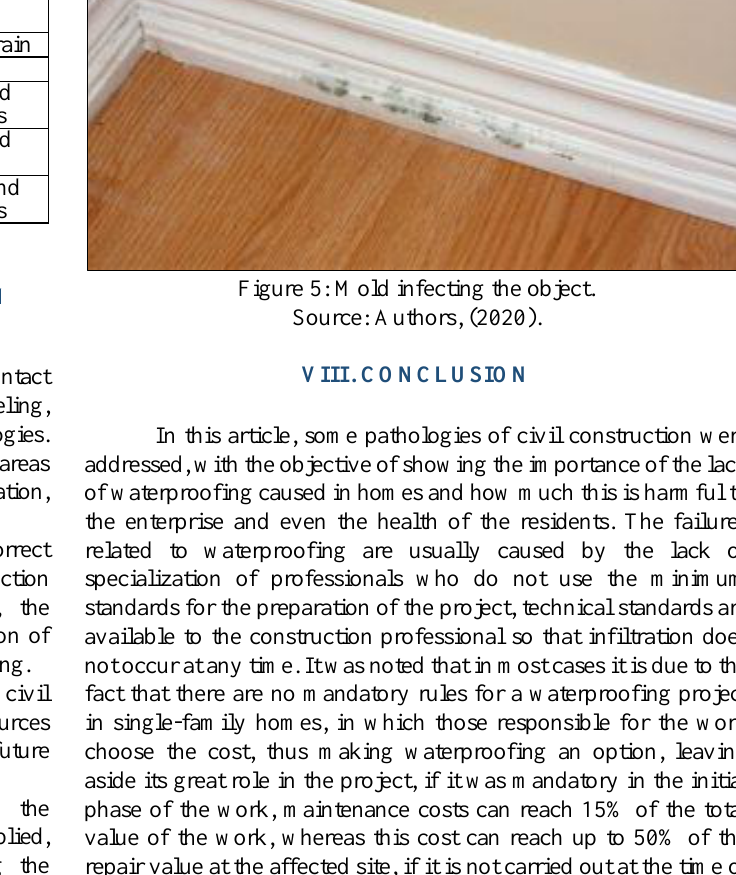
Table 1: Summary of waterproofing solutions. Localization Solution Materials Solid brick Foundations masonry